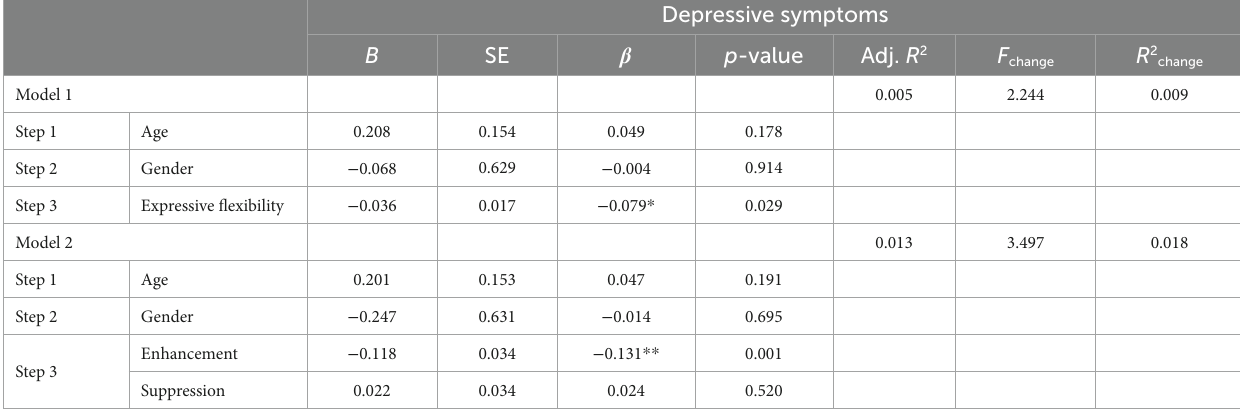
TABLE 2 Regression analyses for the prediction of depression by expressive flexibility among